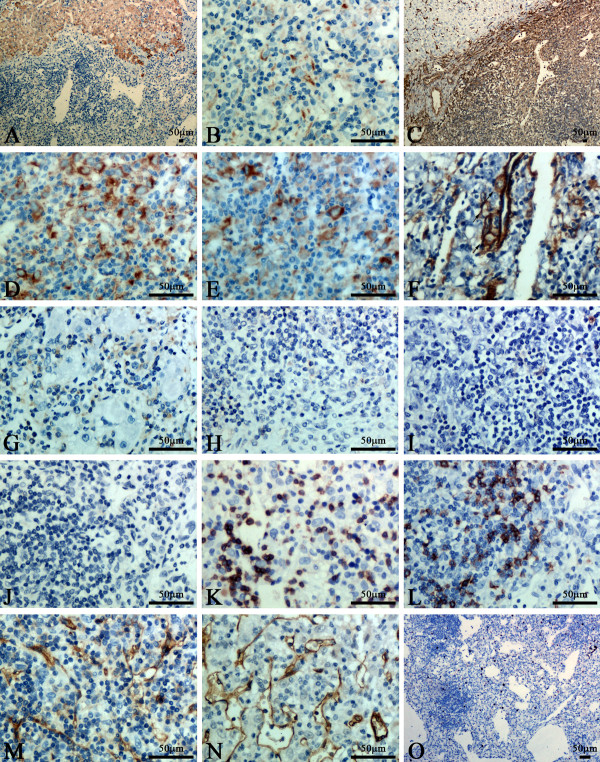
Immunohistochemical staining.A: The liver tissues surrounding the tumor were diffusely positive staining for AE1/AE3. B: The histiocytoid cells were faintly positive staining for AE1/AE3. C-E: The histiocytoid cells were strongly diffuse positive staining for vimentin, HMB-45, melan-A. F: The histiocytoid cells were focally positive staining for smooth muscle actin, especially the cells around blood vessel. G: Scattered tumor cells were positive for CD68. H-J: The histiocytoid cells were negative staining for CD21, S100 and ALK. K and L: The lymphocytes among the histiocytoid cells were mainly positive for CD3 and focally positive for CD20, whereas the histiocytoid cells were negative. M and N: CD31 and CD34 underlined the rich vascular channels, whereas the histiocytoid cells were negative. O: Ki67 index was about 5%.